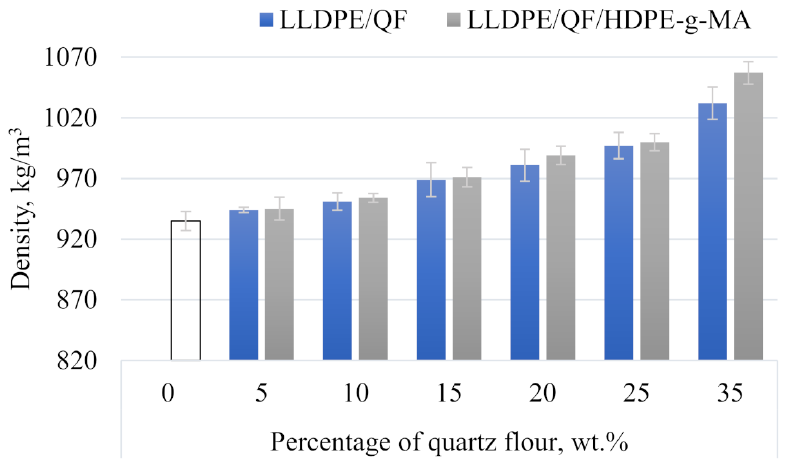
Figure 12. Normal density of LLDPE/QF and